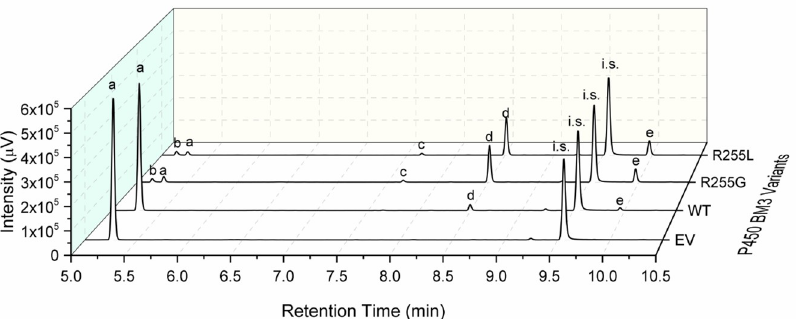
Figure 7. Product analysis using GC-FID after conversion of benzo-1,4-dioxane with lysate from EV (negative control), P450 BM3 WT, and from variants R255G and R255L. The data was obtained